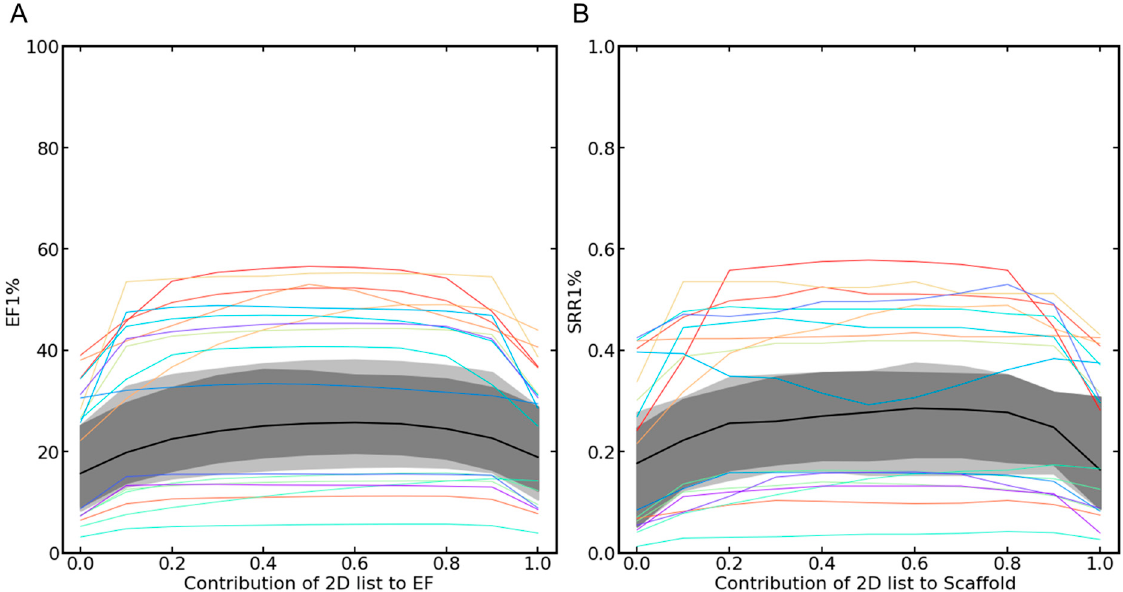
Figure 5. Development of the ( A ) EF1% and ( B ) SRR1% as the proportion of hits selected from the 2D approach was increased. The values on the left side of the two plots reflect the performance of the baseline 3D approach (as no hits from the 2D approach were included in the combined hit list) and the values on the right side show the performance of the baseline 2D approach (as no hits, obtained with the 3D approach, were included in the combined hit list). In the center of the graphs, the performance of the balanced, parallel selection approach is shown. In most cases, the balanced selection was the most favorable setup with respect to all performance measures considered. The median curve is shown as a black line; the envelope of the 50% central region and the maximum non-outlying envelope are visualized in gray, and the outlier curves are shown as colored lines.